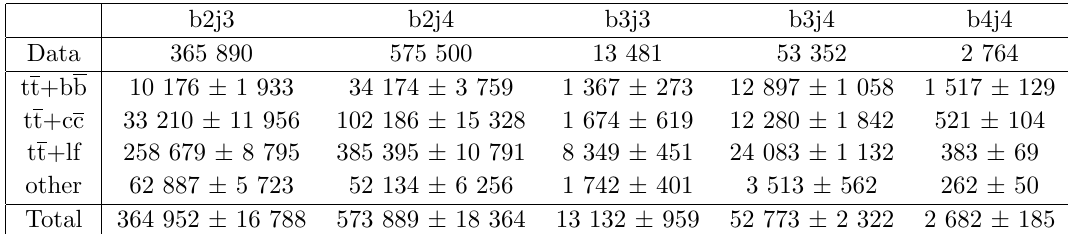
Table 2 . Number of events in each category together with its total relative uncertainty as obtained from the (cid:12)t to data for Hct.